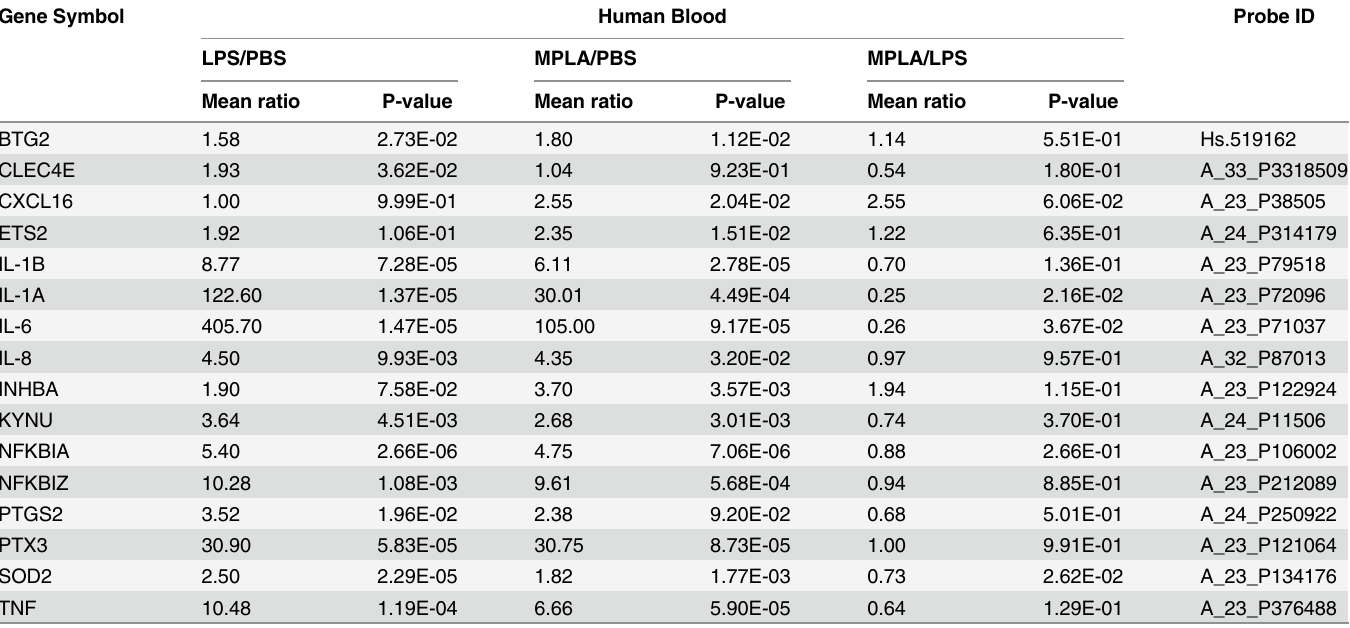
Table 2. Orthologues that changed greater than 1.5-fold in human. Gene Symbol Human Blood Probe